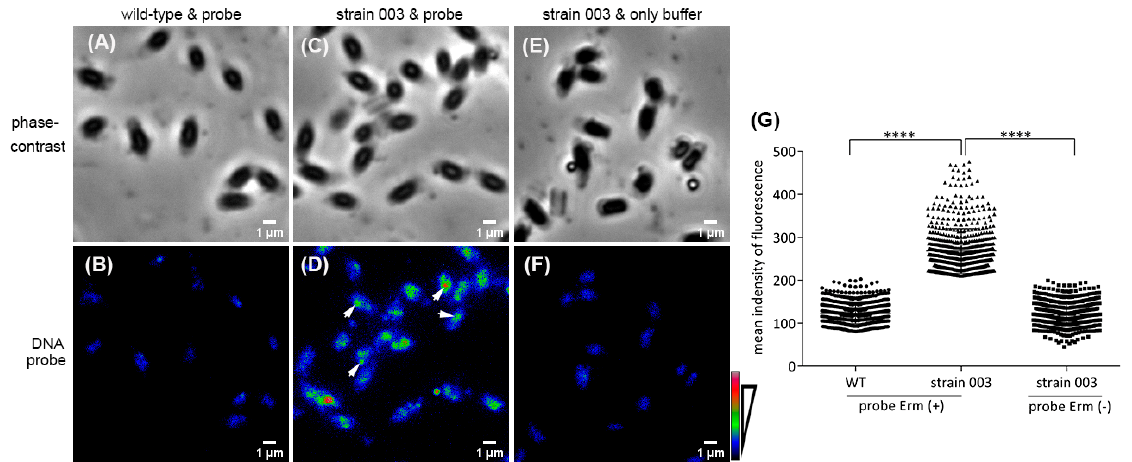
Figure 2. FISH detection of plasmid DNA in spores of B. cereus strain 003. Spores of B. cereus wild-type and strain 003 were analyzed by FISH, and phase-contrast (panels ( A ), ( C ), and ( E )) and probed images (panels ( B ), ( D ), and ( F )) were obtained. Spores of strain 003 hybridized, using buffer, without the DNA probe, as a negative control are shown in panels ( E , F ). The mean fluorescence intensity of 670 individual spores of each strain is shown in panel ( G ). The images of DNA probed samples were given a false color of rainbow RGB (panels ( B ), ( D ), and ( F ); and see scale bar on lower right). The arrows in panel ( D ) indicate some locations of plasmid hybridized with the erm probe. Note that the spores appear dark in the phase-contrast images because of the processing for the FISH detection. ****, p <